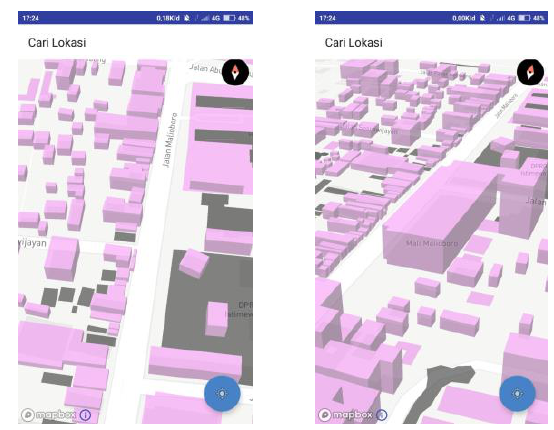
Figure 1. The application development results